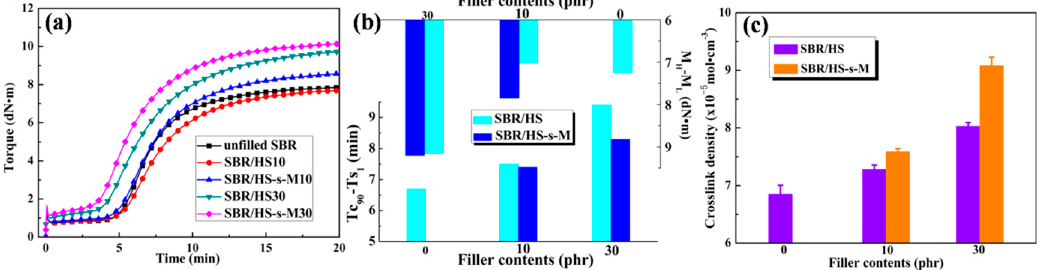
Figure 5. ( a ) Curing curves of SBR compounds at 160 ° C, curing parameters ( b ) and crosslink density ( c ) of SBR compounds with different filler contents.